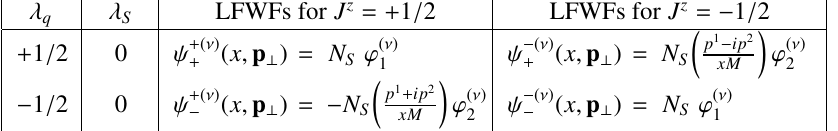
Table 1: The LFWFs for the scalar diquark for the case when J z = ± 1 / 2, for di ff erent values of helicities of struck quark λ q and λ S = 0. N S is the normalization constant.